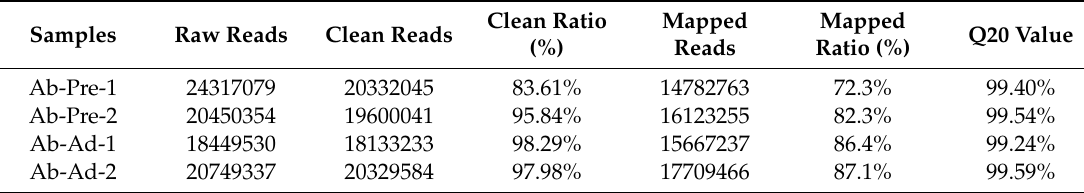
Table 1. Overview of sequencing data for small